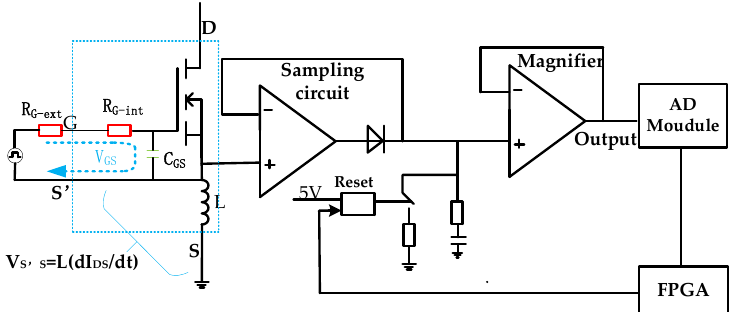
Figure 15. Parasitic inductance induced the voltage V S’S measurement circuit when it is turned on. Energies 2018 , 11 , x FOR PEER REVIEW